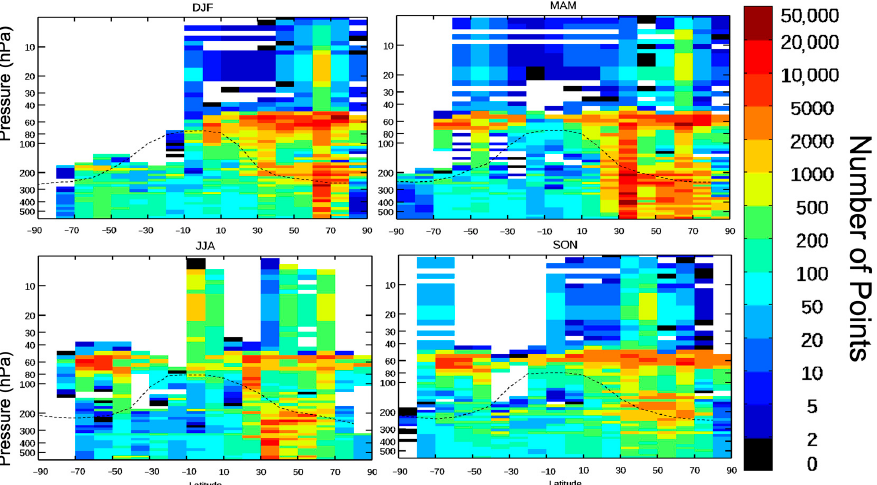
Figure 4. Number of measurements per 10° latitude grid box and 60 levels pressure (600–5 hPa) for all years and seasons: December-January-February (DJF), March-April-May (MAM), June-July-August (JJA), and September-October-November (SON). The dashed black line represents the tropopause pressure according to ECMWF ERA-interim [48].